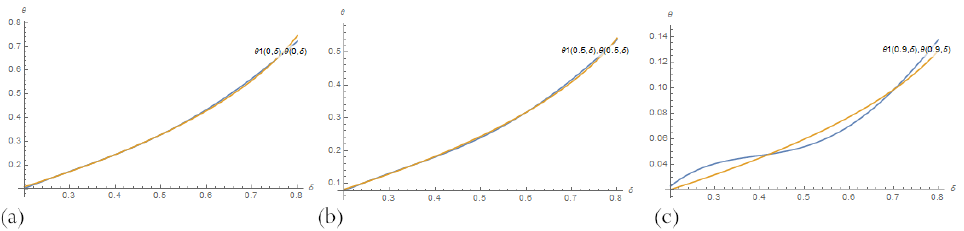
Figure 11. A comparison of parametric PBA-PINN (20), θ 1 ( x , δ ) , n = 3, after two consecutive training weights by minimising the losses (21) and (24), respectively, and an exact solution to the problem for parameter values: ( a ) δ = 0.2; ( b ) δ = 0.5; ( c ) δ = 0.8; and ( d ) error in this PBA-PINN across parameter space 0.2 < δ < 0.8.